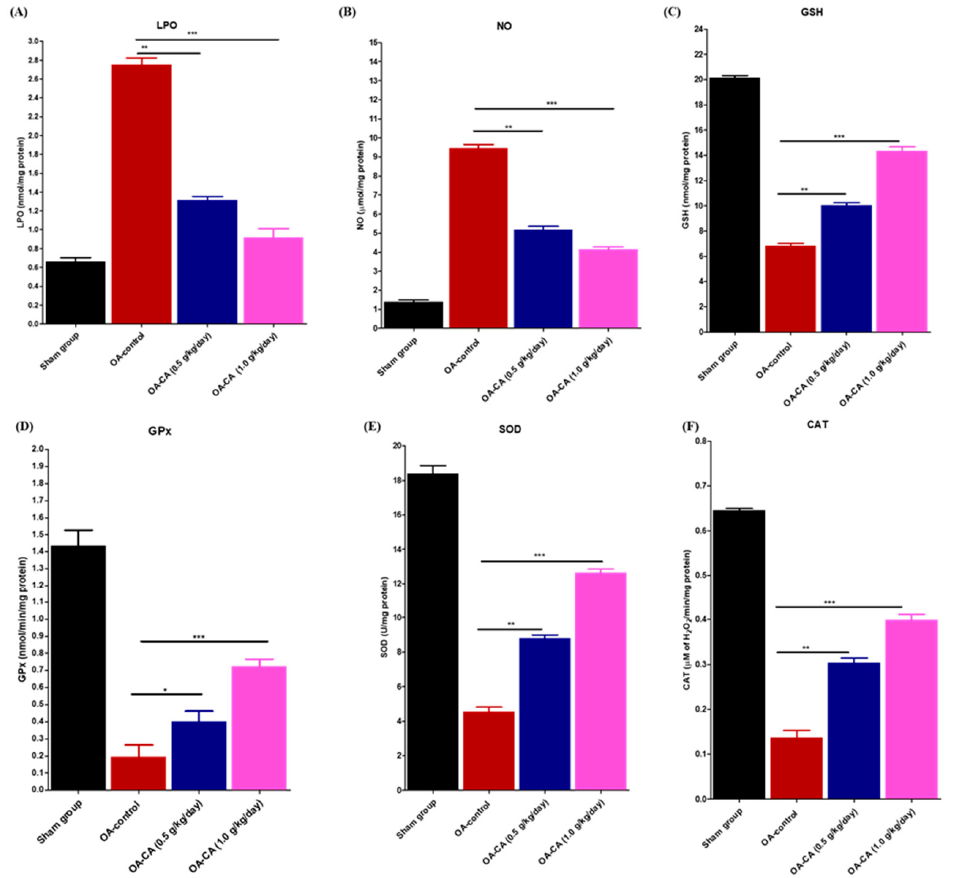
Figure 6. The antioxidant effect of CA was tested in the sham, OA-control, and OA-CA treated groups. The antioxidant biomarkers were measured as ( A ) LPO, ( B ) NO, ( C ) GSH, ( D ) GPx, ( E ) SOD, and ( F ) CAT and are represented in this figure. Data parameters were expressed as LPO (nmol/mg protein), NO ( μ mol/mg protein), GSH (nmol/mg protein), GPx (nmol/min/mg protein), SOD (U/mg protein), and CAT ( μ M of H 2 O 2 /min/milligram protein). Data expressed as means ±S.D.* p < 0.05, ** p < 0.01, and *** p < 0.001.